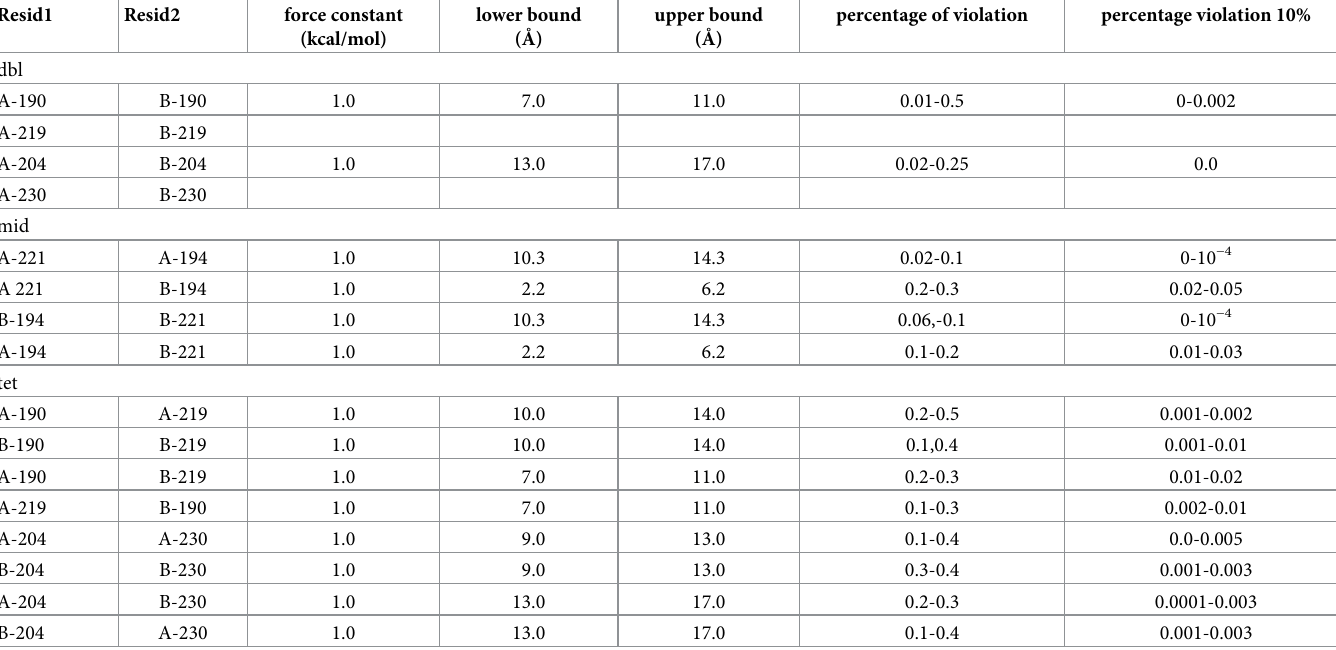
Table 3. Characteristics of the distance restraints used along the TAMD trajectories to prevent the dissociation of HAMP monomers. The involved atoms are C α atoms of the residues given in the two first columns. The ranges of percentages of violations of these restraints along TAMD trajectories are given in the two last column: they correspond to the percentages of frames in which the distance is outside the restraint interval or outside of the interval increased by